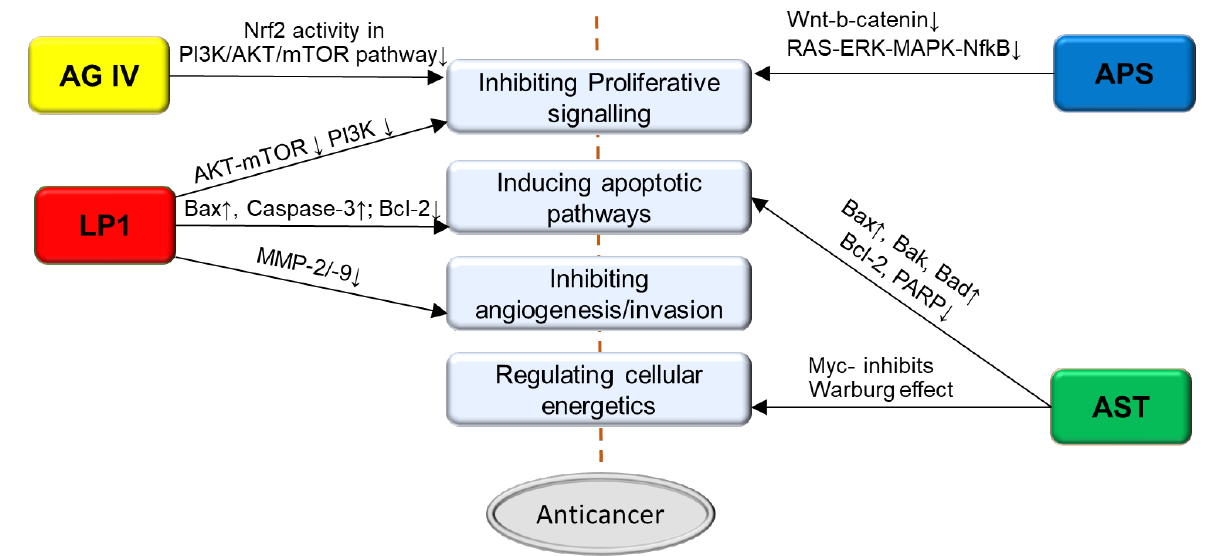
Figure 1. Pathways through which Astragalus and shiitake bioactives compounds mediate antiproliferative and pro-apoptotic effects in cancer cells. (APS – Astragalus Polysaccharides, AST – Astragalus saponins, LP1-Lacriptin domain, AGIV- Astragaloside IV).